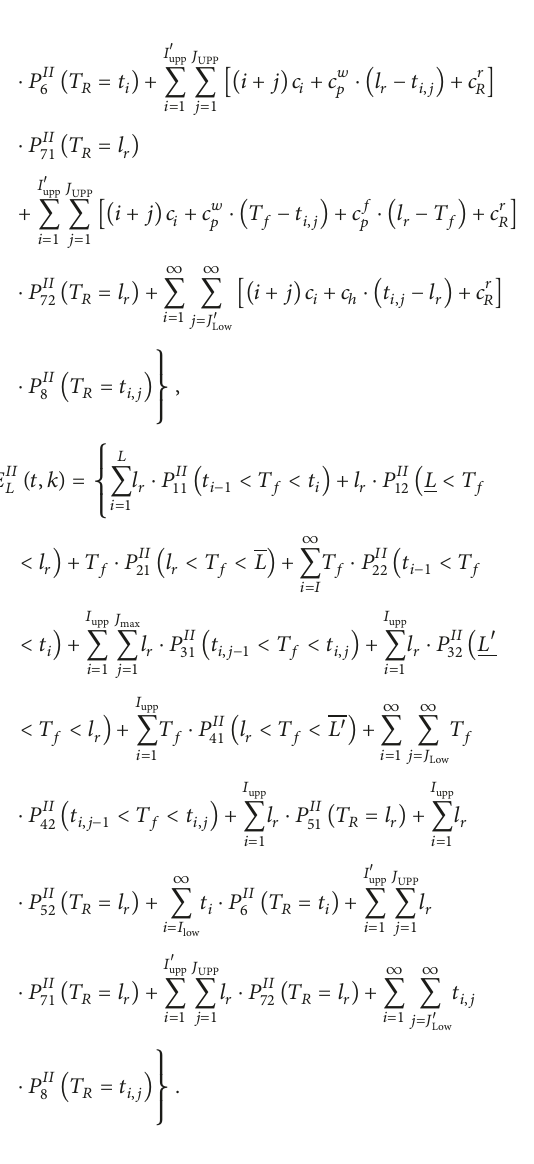
is one of the most common distributions in reliability studies [22]. The probability density function (PDF) of the Weibull distribution is shown in (34), in which 𝛼 𝑛 and 𝛽 𝑛 denote the scale parameter and the shape parameter, respectively. Fur-